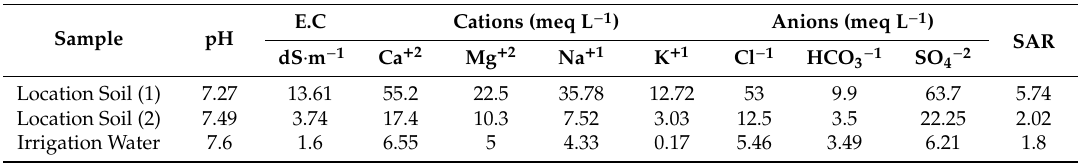
Table 2. Chemical properties of soil and